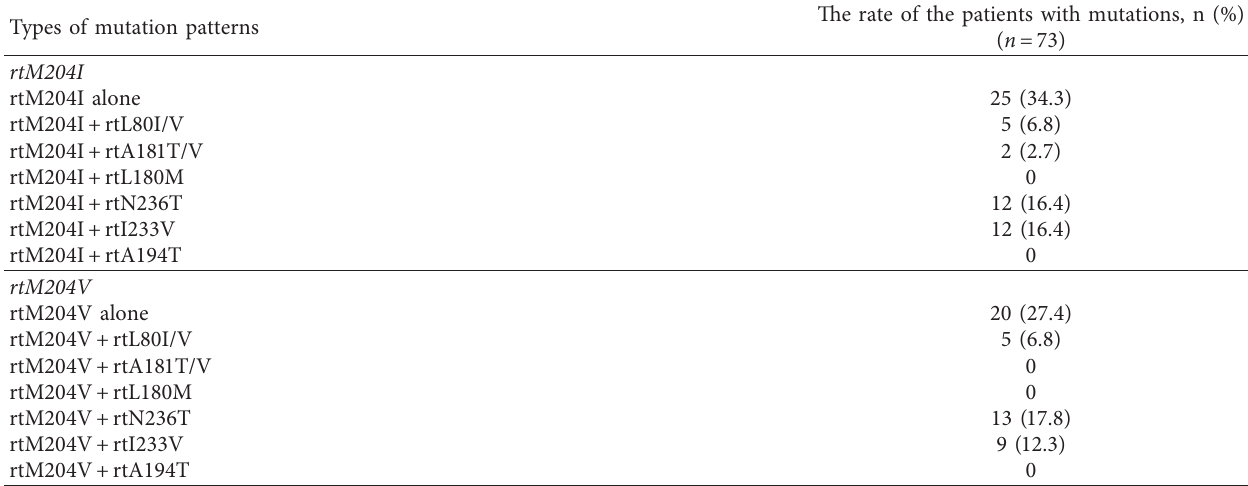
Table 3: The multi-base mutations combined with rtM204I/V.